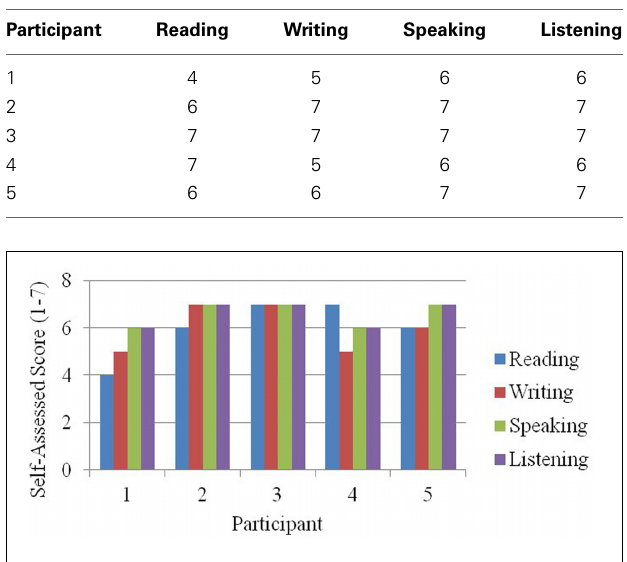
FIGURE 6 | Self-assessed reading, writing, listening, and speaking ability for the five participants described in Table 1. This bar graph recoding of the data from Table 1 is the first step in the development of visual participant